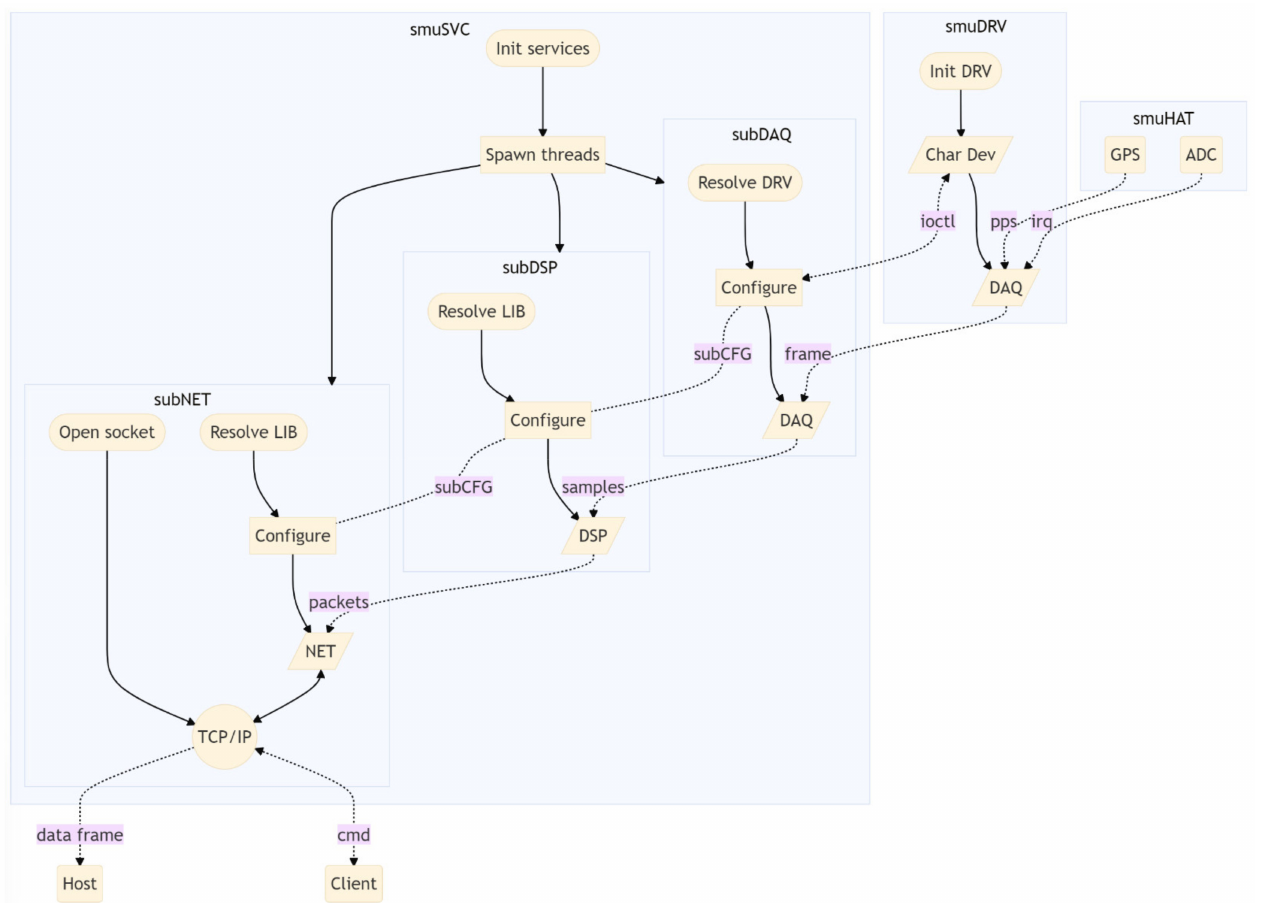
Figure 4. Software architecture: the driver provides access to the hardware resources via standard IOCTL system calls; the main service is composed of 3 sub-modules that run on separate